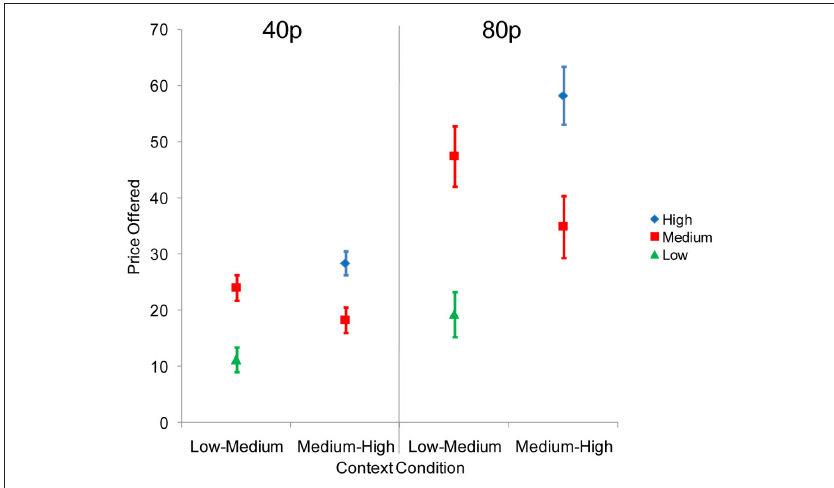
Figure 1 | Mean price offers (in pence) for the three pain levels, depending on endowment and context pairing (Vlaev et al., 2009). Error bars indicate standard errors of the mean. The medium pain provoked markedly higher price offers when it occurred with low pain in both 40 pence and 80 pence endowments. All pain levels received higher offers when the endowment per trial was